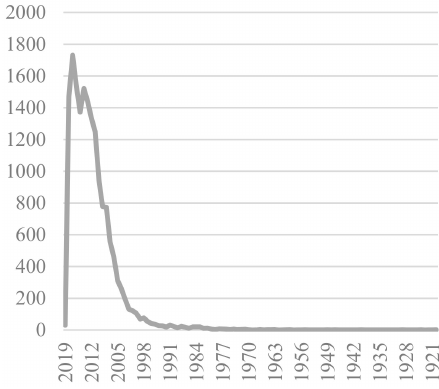
Figure 2. Evolution of scientific research on green